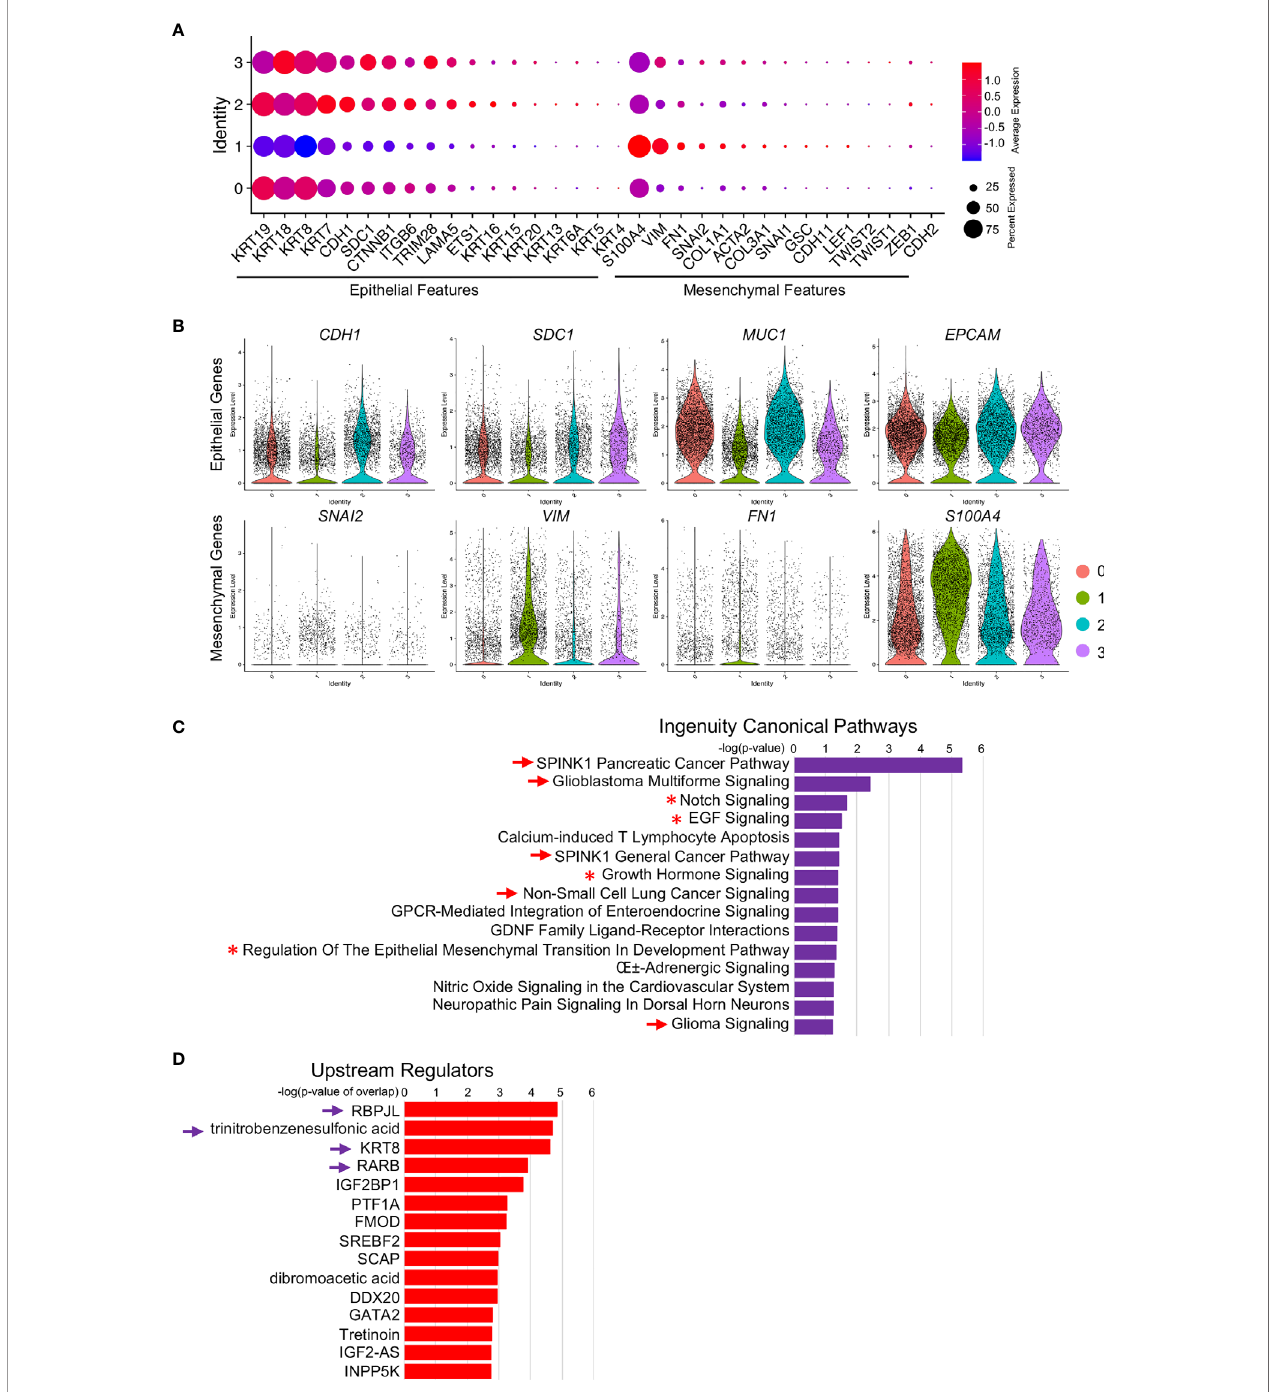
FIGURE 7 | Increased EMT signatures in MEG3 + cancer cells. (A) Relative expression of EMT markers, including epithelial markers and mesenchymal markers, in each cluster were visualized by dot plot. (B) Decreased epithelial cell marker signatures and increased mesenchymal marker signatures in Cluster 1 were con fi rmed by violin plot visualization of representative EMT marker expression: CDH1 , SDC1 , MUC1 , EPCAM , SNAI2 , VIM , FN1 and S100A4 . (C, D) Ingenuity Canonical Pathways (C) and Upstream Regulators (D) of Cluster 1 determined by IPA on signi fi cant DE genes. The arrow and arrowhead indicated signaling pathways and upstream regulators were cancer or cancer metastasis related. Asterisk indicated the EMT signaling